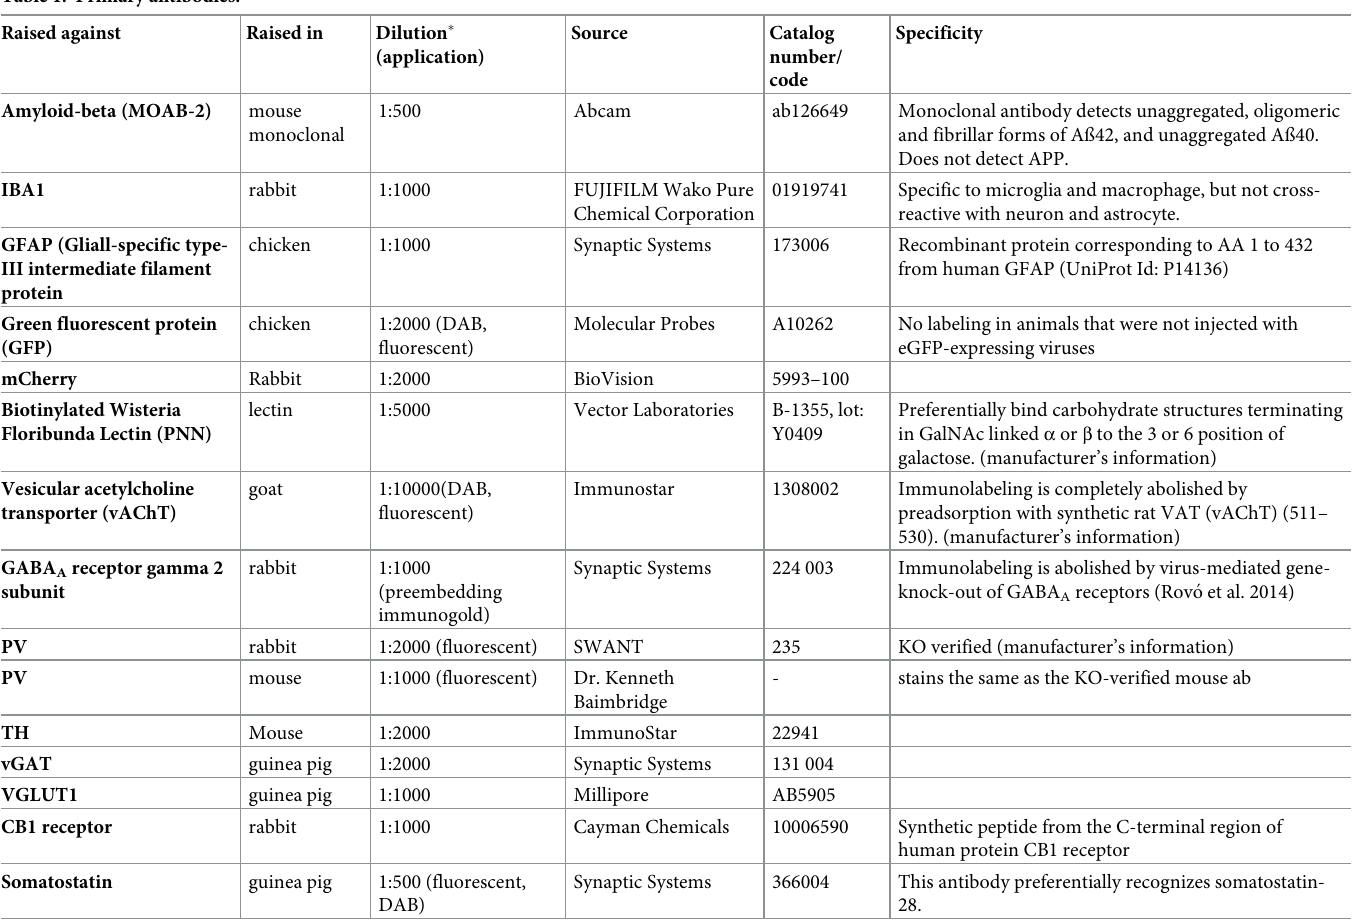
Table 1. Primary antibodies.